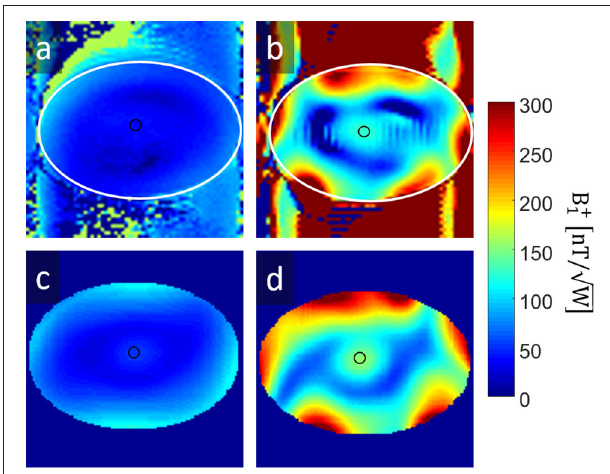
FIGURE 4 | Comparison between measured and simulated data for the two coils. The first row shows B + 1 maps in the tissue-simulating liquid phantom (white oval) with the ROI in the center marked by the black circle for (a) the integrated array and (b) the local array, while (c,d) show the corresponding results from RF simulations.